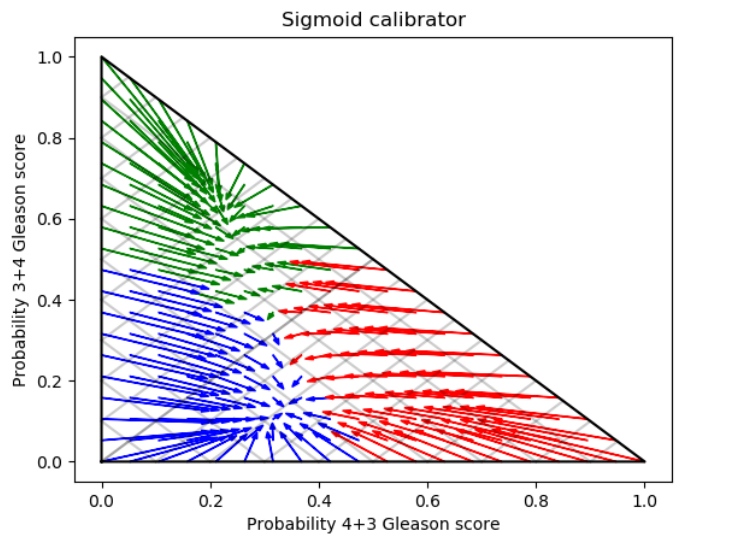
Figure 5. Calibrated